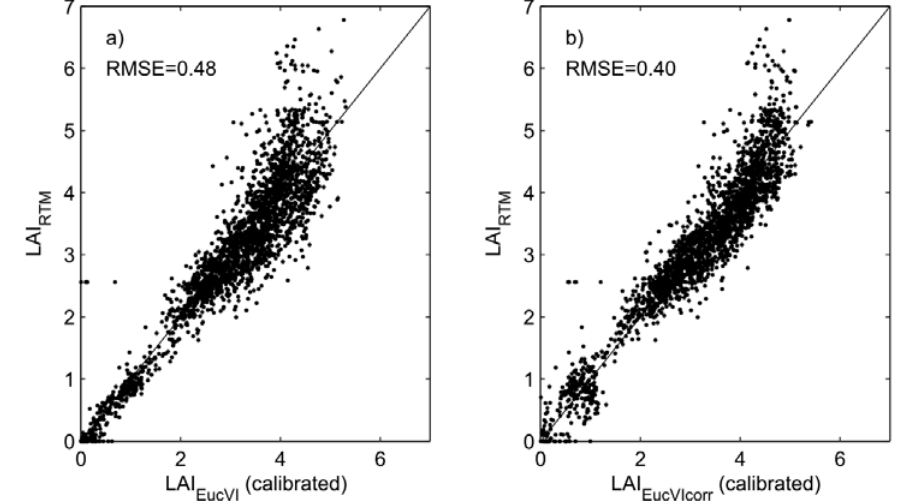
Figure 1. ( a ) Results of the calibration of EucVI: Parameters of Equation 1 were estimated by minimizing the RMSE between LAI estimated from EucVI (LAI ) and LAI EucVI ). ( b ) Results of the calibration of EucVI which estimated by RTM inversion (LAI RTM corr takes into account age and DoY (Equation (2)). The data consist of 2620 LAI estimates obtained by RTM inversion, using Red and NIR MODIS reflectances of 18 different stands of different ages and soil conditions, from their planting date up to year